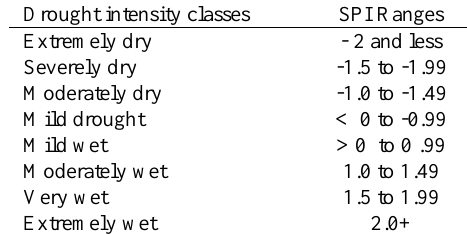
Table 1. Intensity classification of SPI values Drought intensity